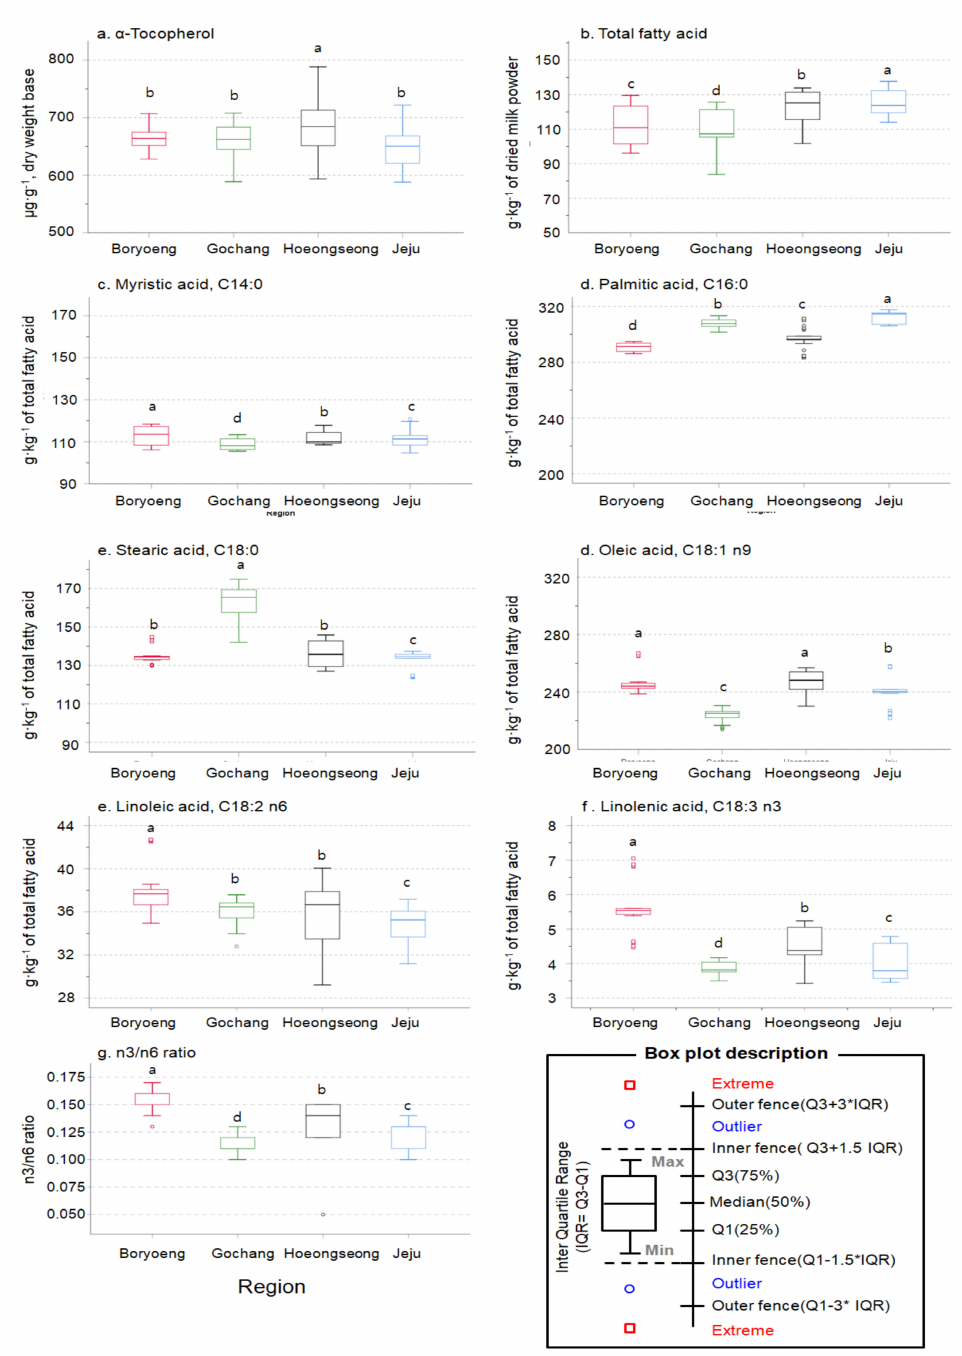
Figure 1. Regional di ff erences of α -tocopherol ( α -TOC) and the selected representative fatty acid (FAs) contents in organic milk (OM, n = 25 per each region, p < 0.05).e. Linoleic acid, C18:2 n6 f. Linolenic acid, C18:3 n3 g. n3 / n6